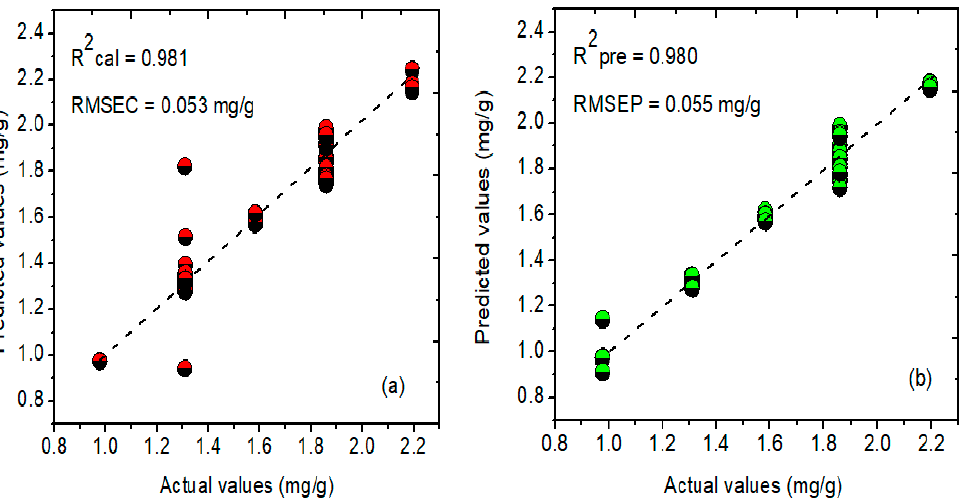
Figure 8. Actual and predicted concentration values for the phenolic compounds in A. thaliana leaf powder samples using the PLSR model for ( a ) calibration and ( b ) prediction datasets. Here, RMSEC and RMSEP represent root-mean-square error for calibration and prediction.